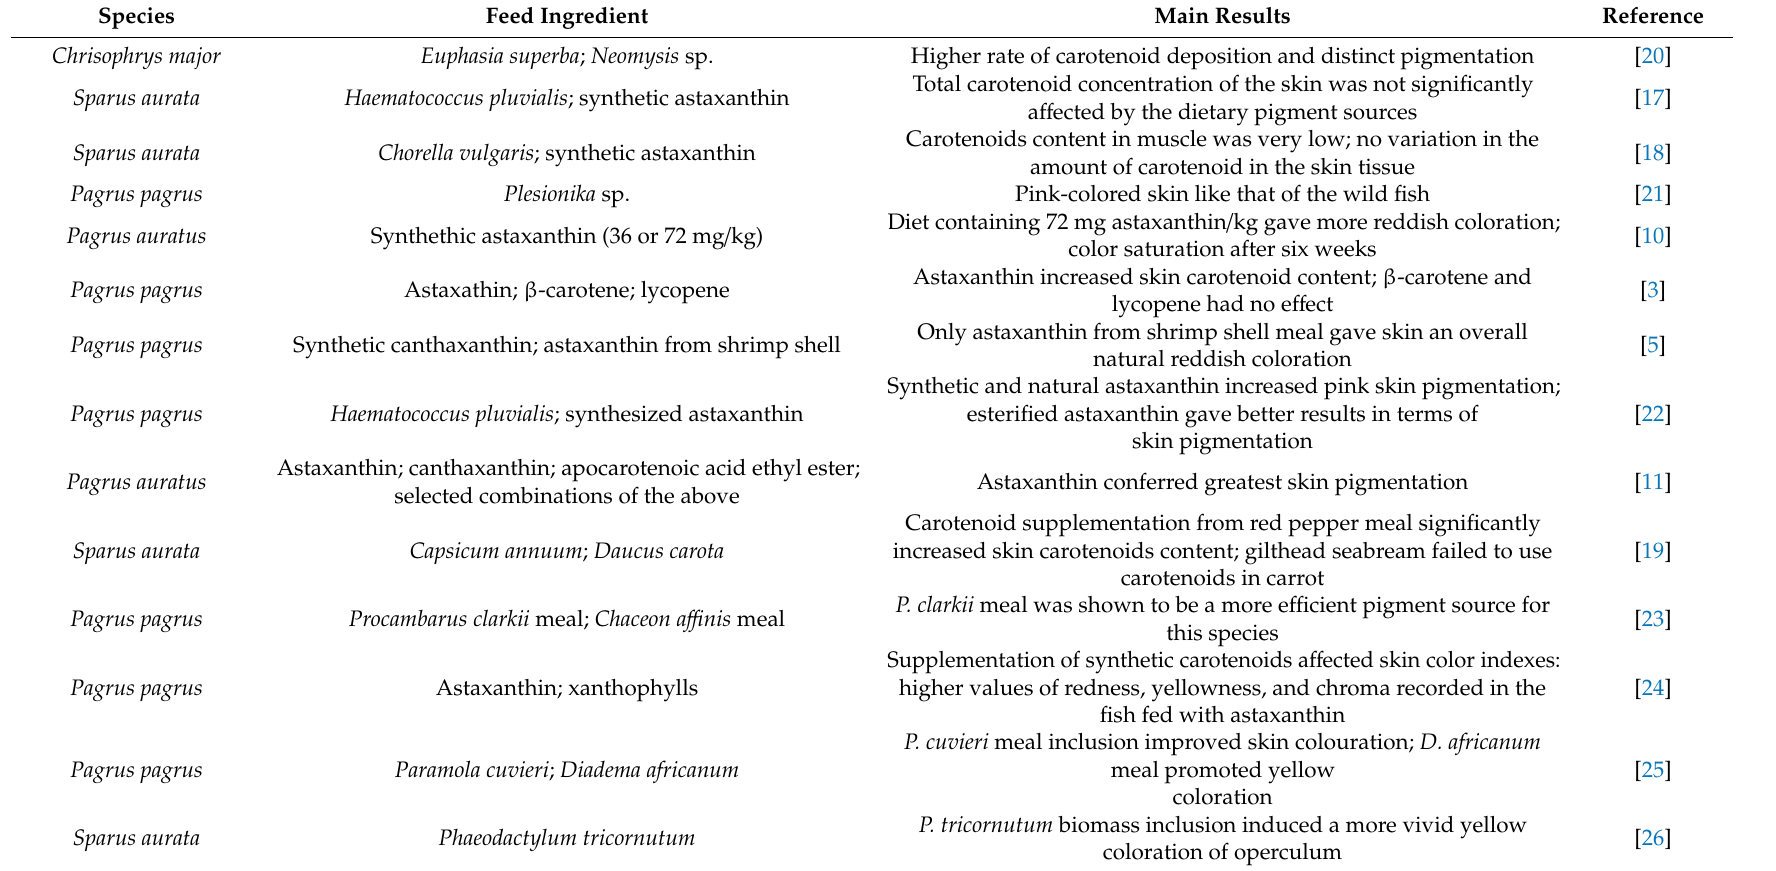
Table 1. E ff ects of diet on skin pigmentation in Sparidae—available